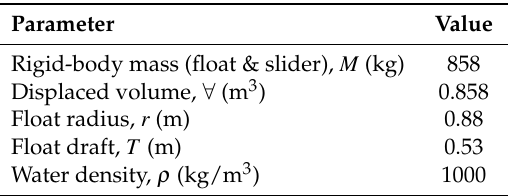
Table 1. Model-scale WEC physical